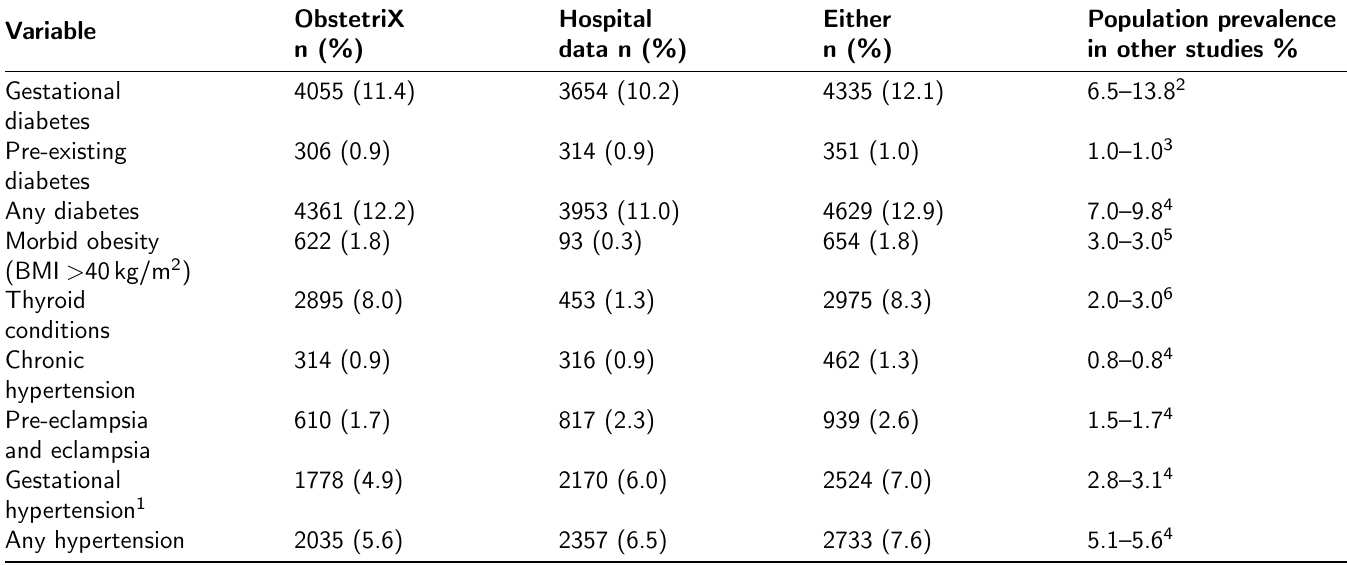
Table 3: Rates of diagnoses across two hospitals in New South Wales, 2011–2015, reported in ObstetriX and coded hospital data, compared to estimated population prevalence based on other